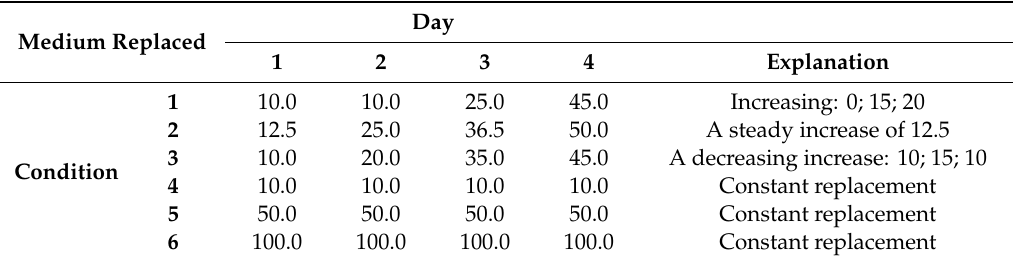
Table 1. Overview of medium replacement strategies. The amount of medium replaced is indicated as a percentage of the total working volume of the well, which changed over the di ff erent days. Day Medium Replaced 1 2 3 4 Explanation 1 10.0 10.0 25.0 45.0 Increasing: 0; 15; 20 2 12.5 25.0 36.5 50.0 A steady increase of 12.5 3 10.0 20.0 35.0 45.0 A decreasing increase: 10; 15; 10 Condition 4 10.0 10.0 10.0 10.0 Constant replacement 5 50.0 50.0 50.0 50.0 Constant replacement 6 100.0 100.0 100.0 100.0 Constant